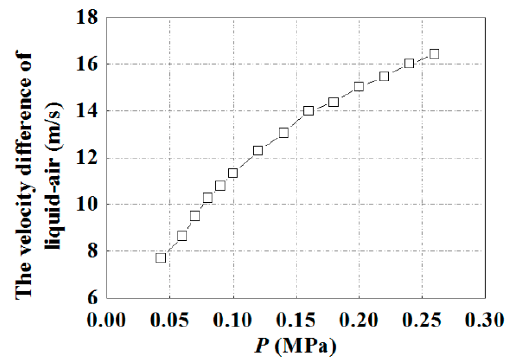
Figure 5. The velocity difference of liquid-air as a function of feeding pressure ( P ). Table 3. The velocity di ff erence of liquid-air.